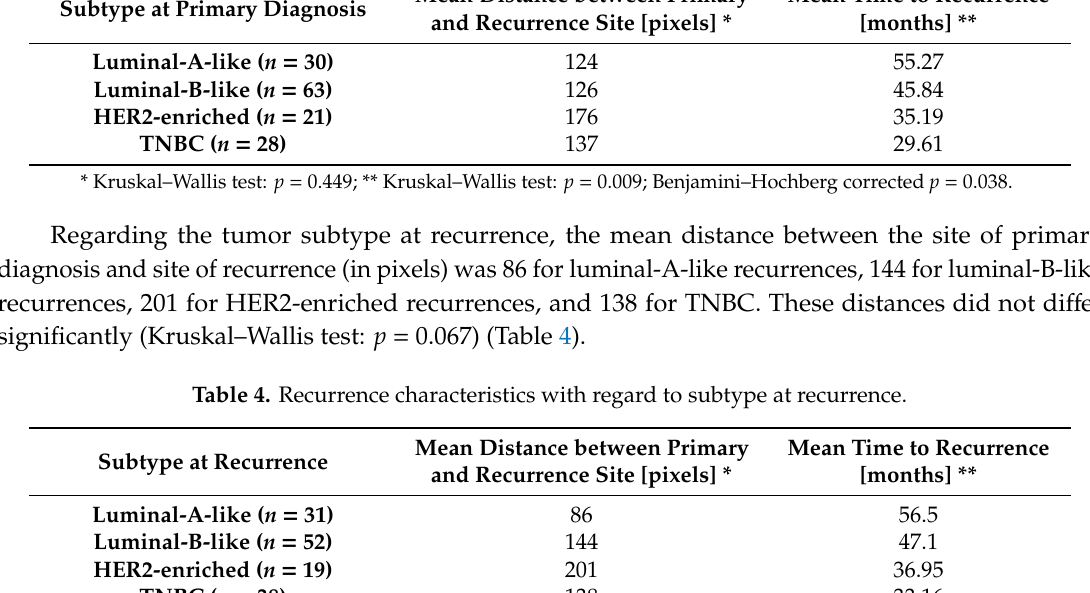
Table 3. Recurrence characteristics with regard to subtype at primary diagnosis. Subtype at Primary Diagnosis